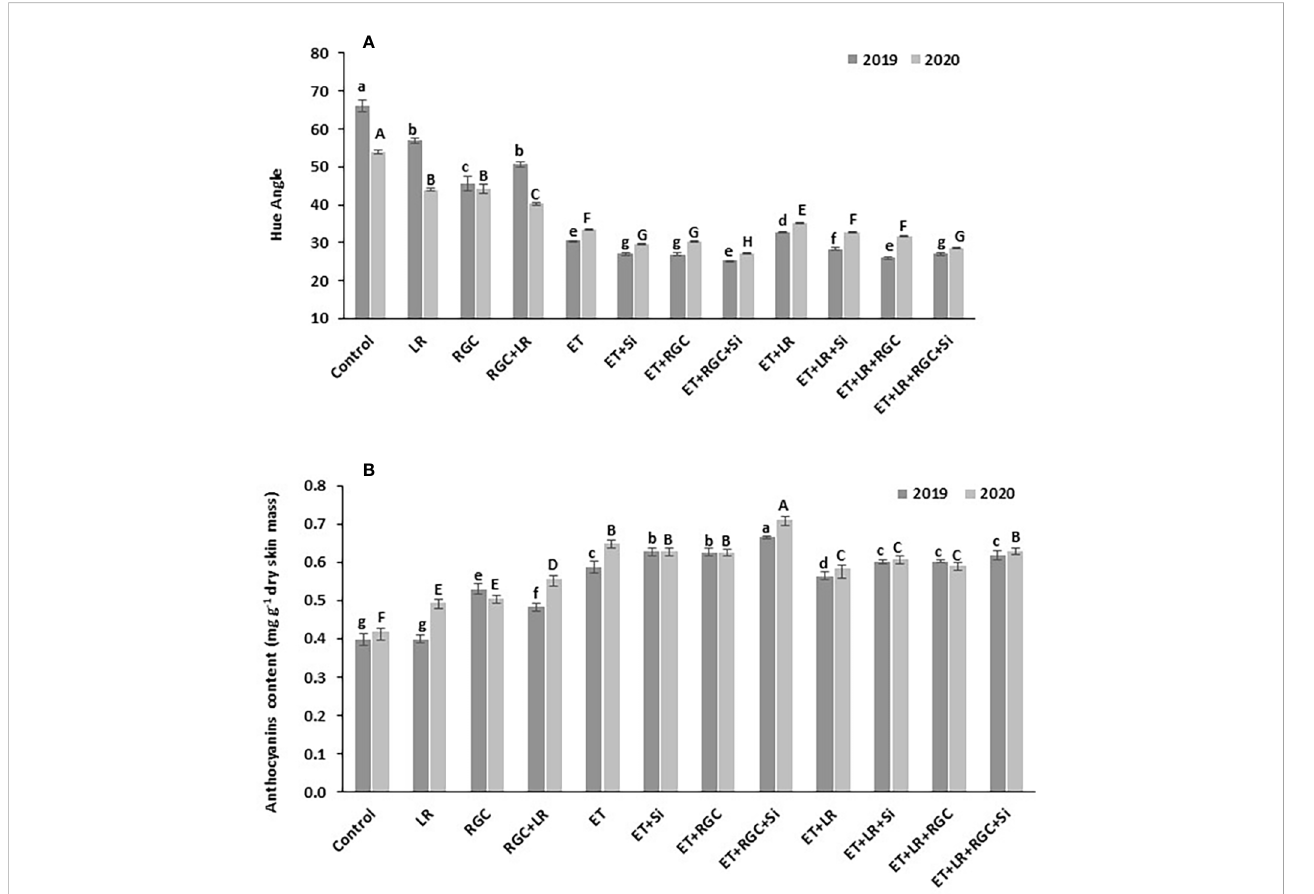
FIGURE 5 Average of hue angle for Flame Seedless grapes (A) and anthocyanin content (B) as affected by the different treatments. Treatments were: ethephon (ET), silicon 7% (Si), light-re fl ective ground cover (RGC), and their combinations. Treatments have been conducted with or without cluster-zone leaf removal (LR). Values are the mean of four readings, and the error bars represent the standard deviation. Different letters on bars indicate signi fi cant differences within the same year at p < 0.05 according to the Tukey HSD test within the same season. Different lower-case letters indicate a signi fi cant difference in 2019 while capital letters are used for